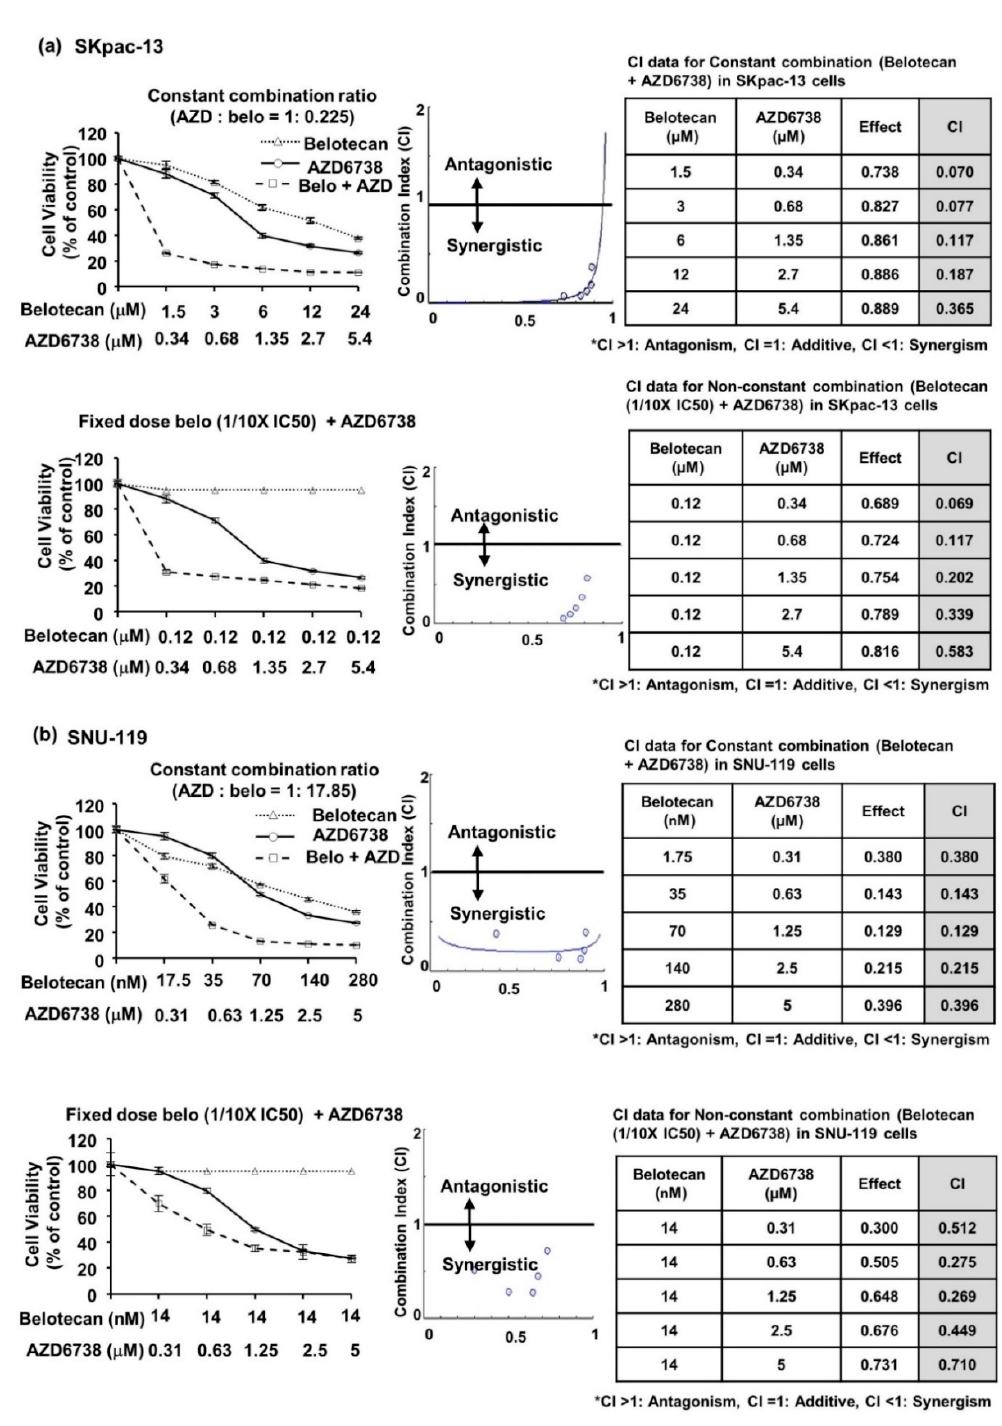
Figure 1. Thiazoyl blue tetrazolium bromide (MTT) assay demonstrated that AZD6738, an ataxia telangiectasia and Rad3-related protein (ATR) inhibitor, in combination with belotecan synergized in vitro epithelial ovarian cancer cell lines. ( a , b ) Combination of belotecan and AZD6738—in a constant combination ratio of both drugs or in a fixed dose of belotecan (1/10 IC 50 ) and varying concentrations of AZD6738—demonstrated synergistic cytotoxicity in both SKpac-13 ( a ) and Seoul National University-119 (SNU-119) cells ( b